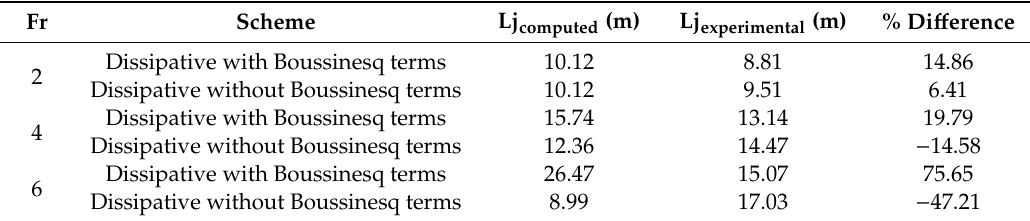
Table 3. Length of jump for 2 m wide open channel.